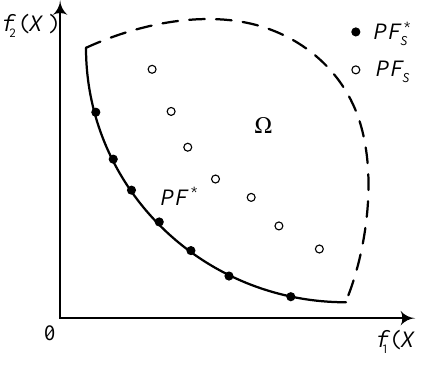
Figure 3. Pareto front of population.